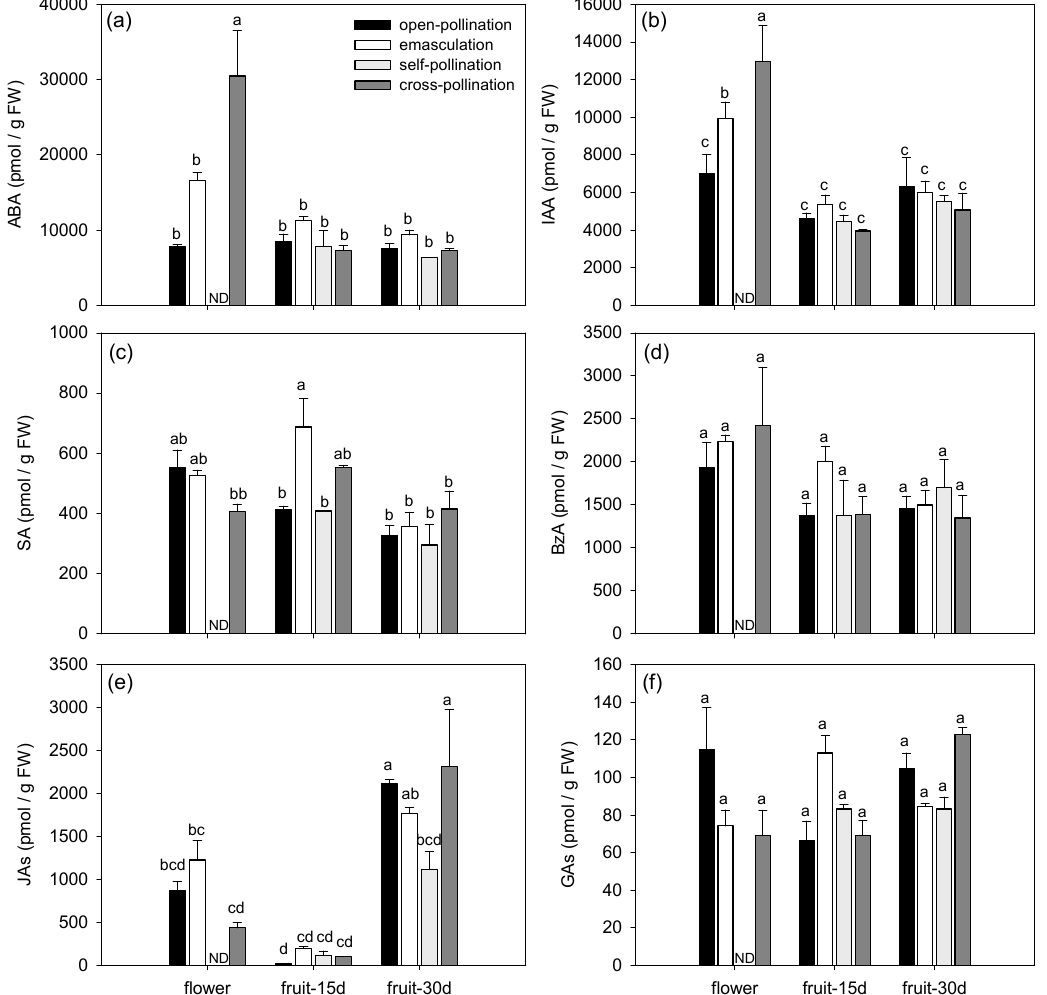
Figure 1. Endogenous phytohormone profile during early fruit development of fertilized and intrinsic parthenocarpic ‘Conference’ pear fruits. ( a ) Total abscisic acid (ABA), ( b ) total auxins (IAA and its derivatives), ( c ) salicylic acid (SA), ( d ) benzoic acid, ( e ) total jasmonates (JAs), and ( f ) total gibberellins (GAs).